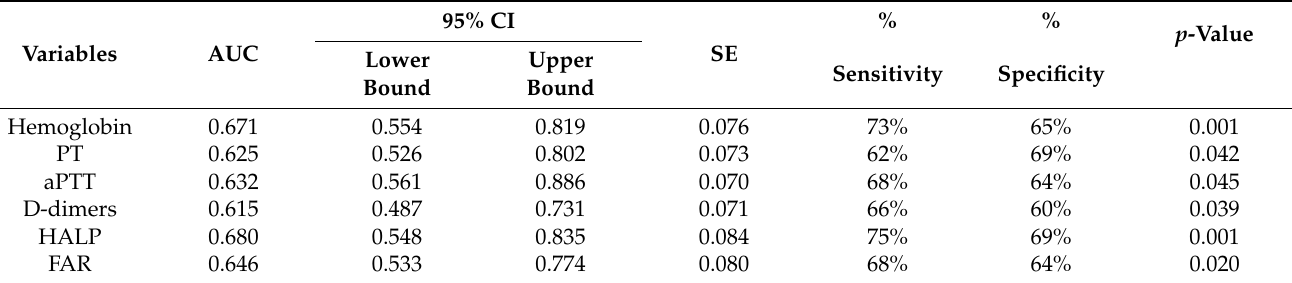
Table 3. ROC plot for the variables involved in estimating the risk for preterm birth.